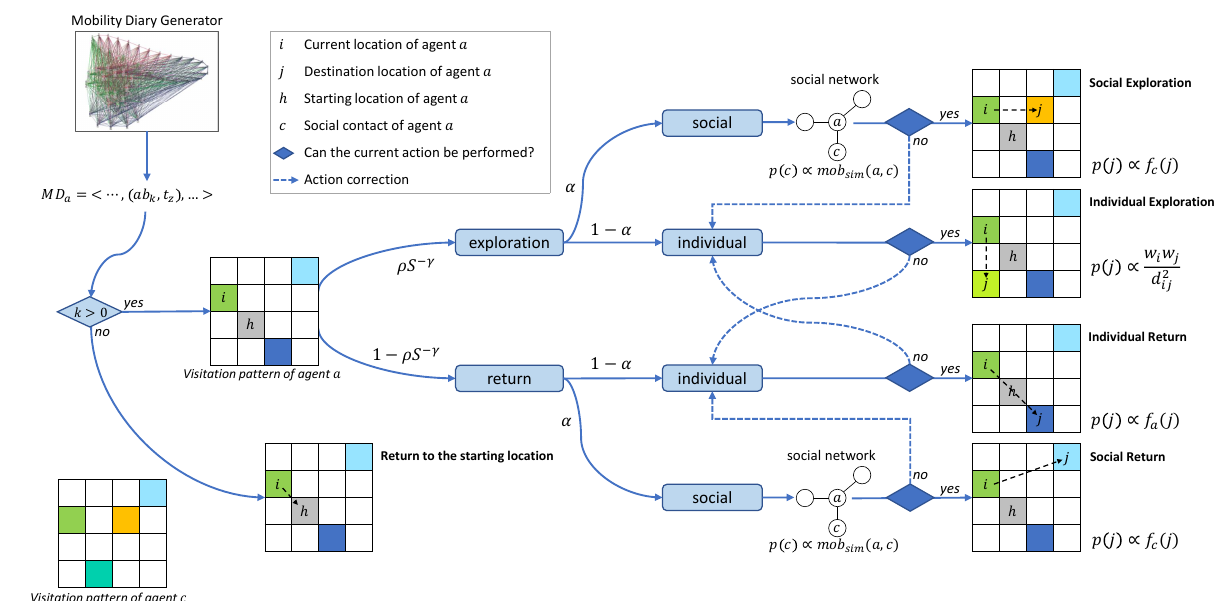
Figure 1. A schematic description of STS-EPR. When an agent a moves according to the entry in its mobility diary MD a , if the abstract location is ab 0 the individual returns to its starting location, otherwise it decides whether to explore a new location or return to a previously visited one. At that point, a determines whether or not its social contacts affect its choice for the location to visit next. If the selected action cannot be performed, it is corrected with an executable one (dashed arrows indicate action